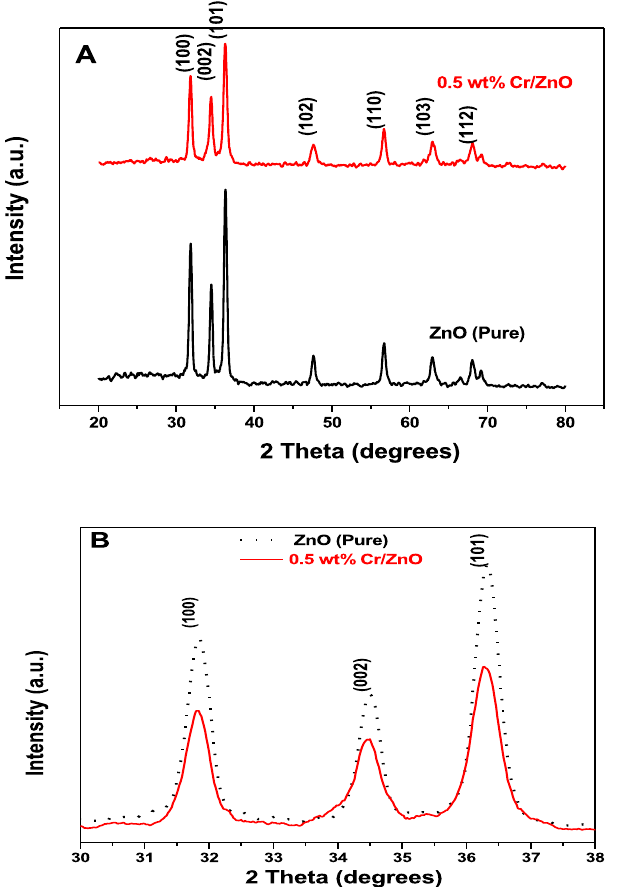
Figure 3. ( A ) X-ray diffraction patterns for the ZnO (Pure) and 0.5 wt% Cr/ZnO films and ( B ) X-ray diffraction peaks of the most intense reflections for the ZnO (pure) and 0.5 wt% Cr/ZnO